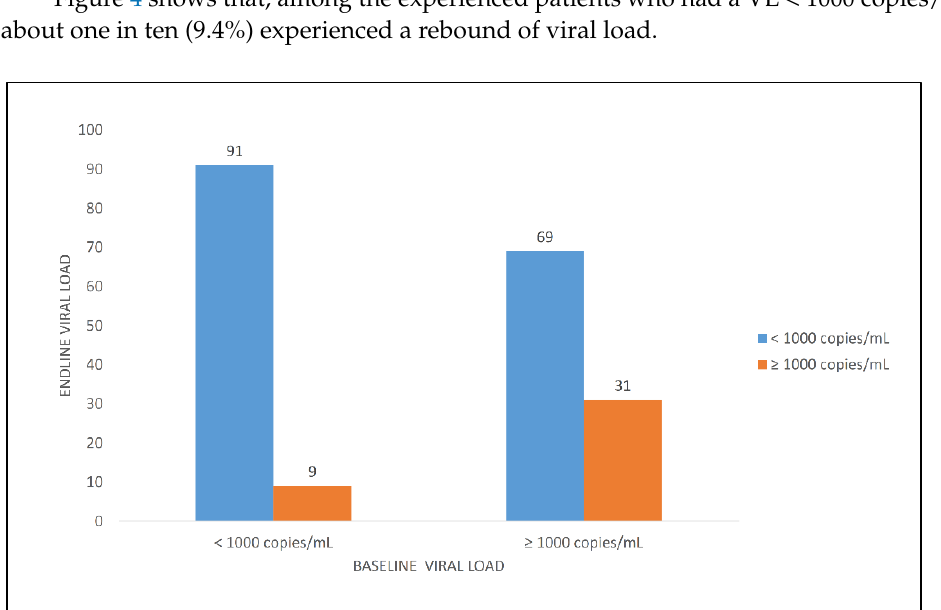
Figure 4. Change of viral load among experienced patients ( n = 220).